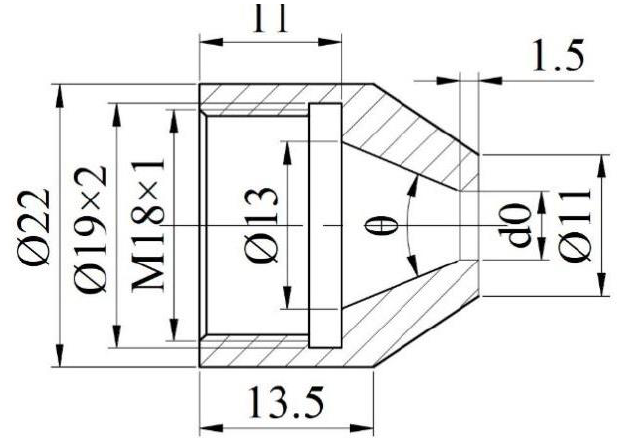
Figure 1. Schematic diagram (cross-section) of a circular nozzle structure with dimensions (mm).